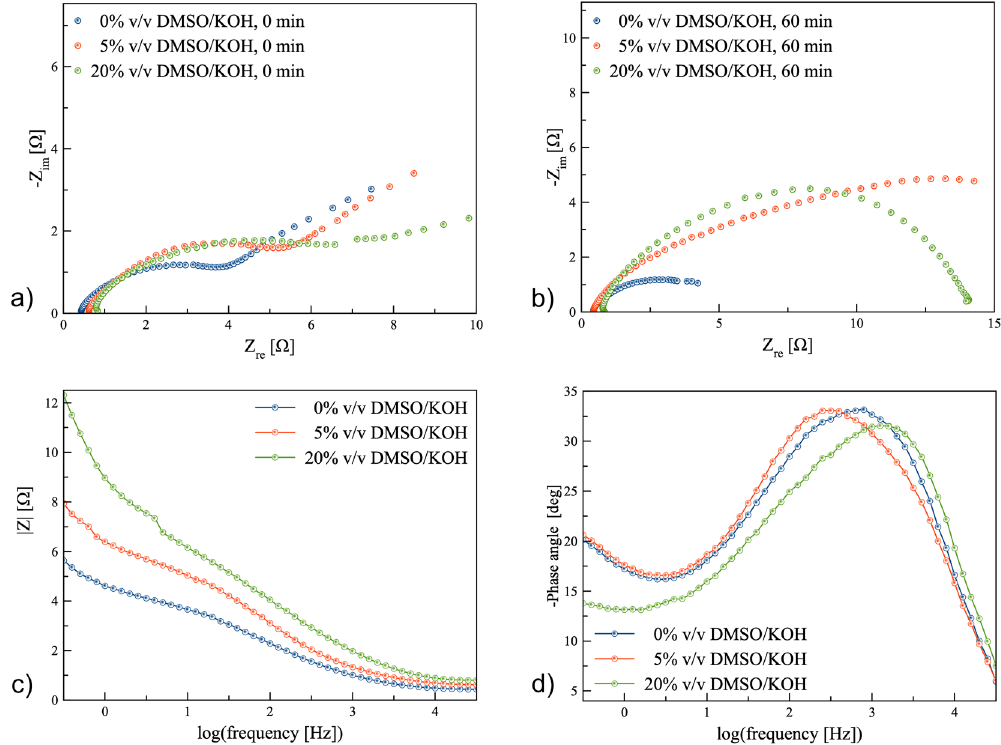
Figure 4. Electrochemical Impedance spectroscopy performed at the potential 0.0 V (vs. OCV) in the frequency range 100 kHz to 0.01 Hz with alternate current amplitude of 10 mV: ( a ) Nyquist plot of 0%, 5%,